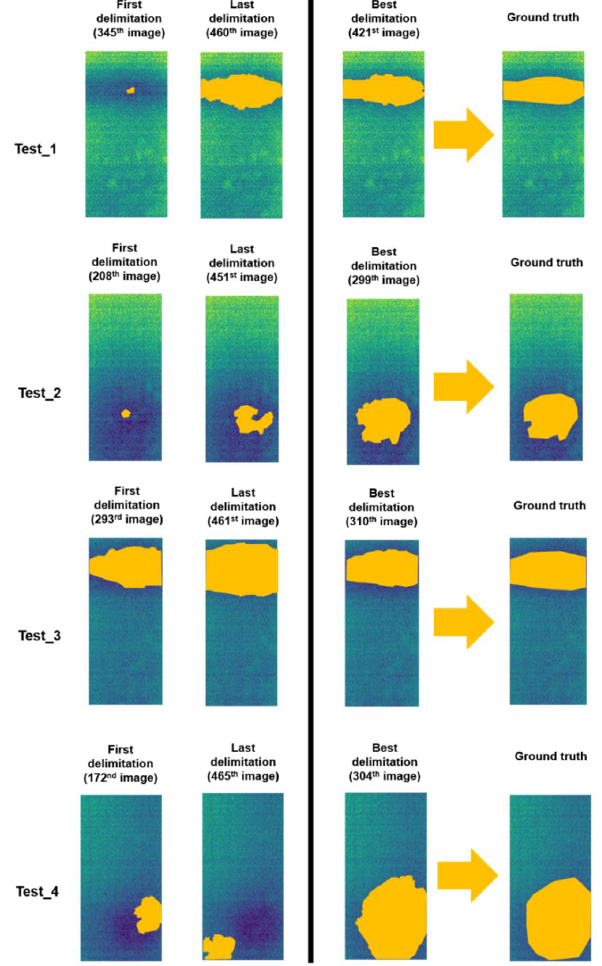
Figure 11. First and last delimitation obtained from each test. The best delimitation according to the F-score results together with the corresponding ground truth of each test are also indicated. All the delimitation areas are highlighted in orange.